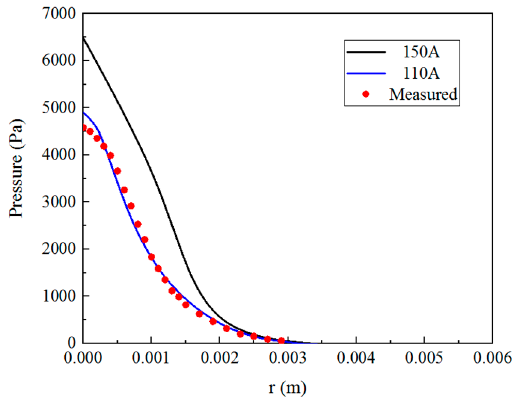
Figure 13. Comparison of calculated arc pressure and measured pressure on workpiece surface.